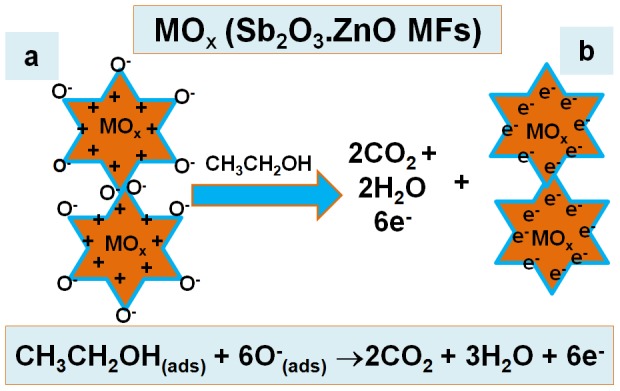
Mechanism of Sb2O3-ZnO MFs/μ-chip ethanol chemical sensors at ambient conditions.